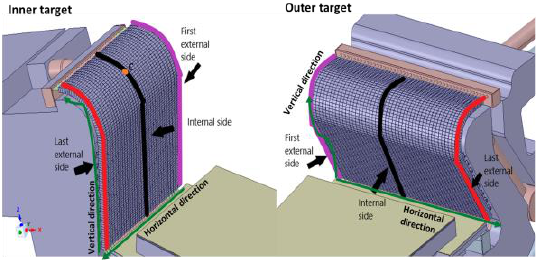
Figure 7. Inboard ( left ) and outboard ( right ) targets (CAD model [27]), highlighting the external sides, the innermost side with the point C on the inboard baffle region and the horizontal and vertical abscissa along the toroidal and poloidal direction, respectively.